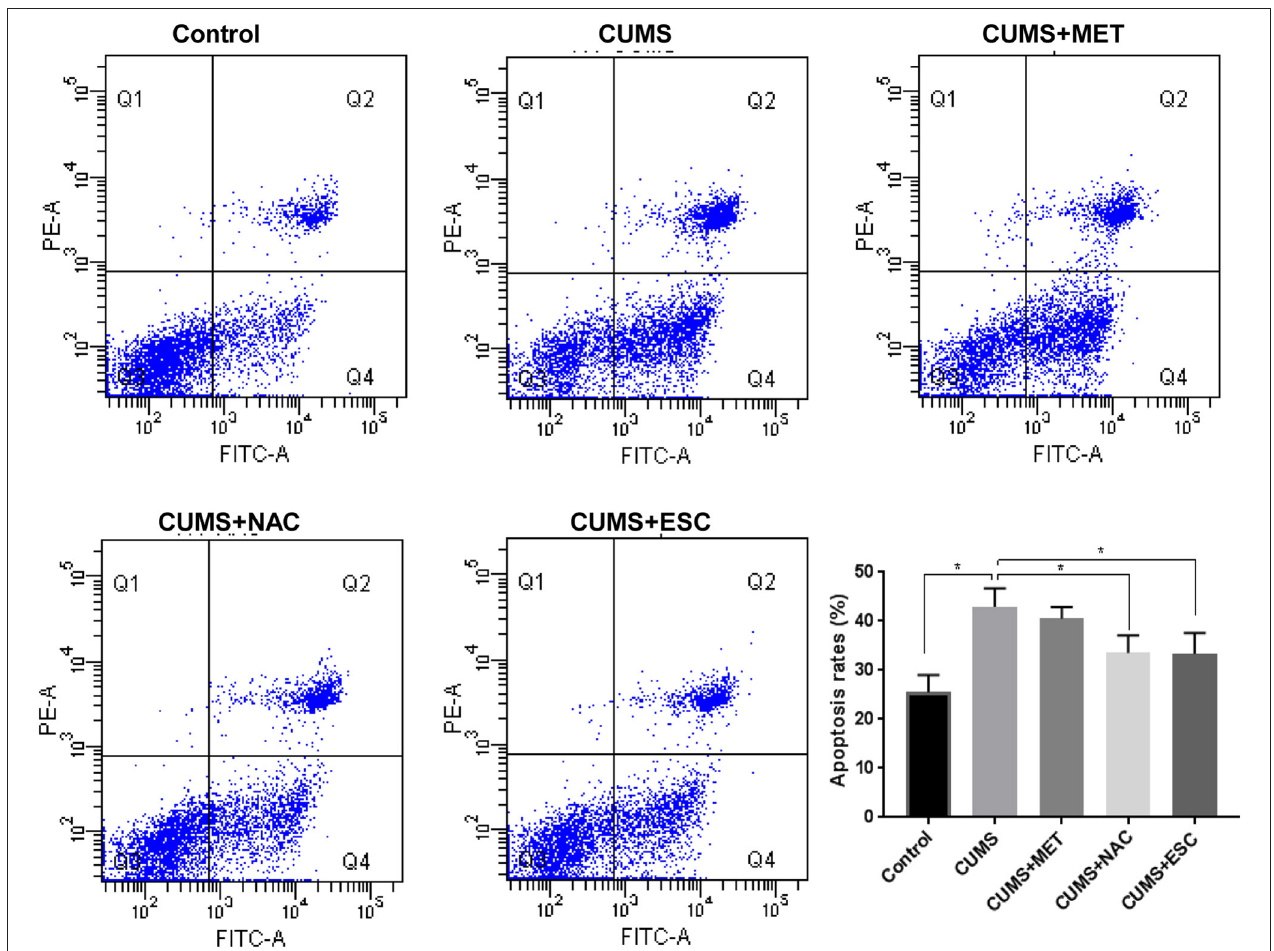
FIGURE 3 | Effect of MET, NAC, and ESC on the apoptosis rates of hippocampus cells after stress. * P < 0.05 (one way ANOVA), n =